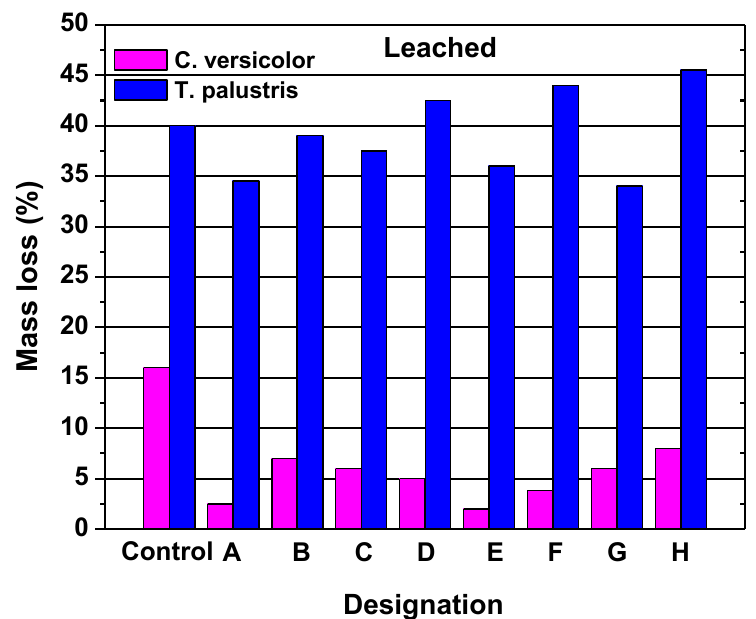
Figure 6. The mass loss (%) following a decay test for leached pine wood: ( A ) nanozinc oxide; ( B ) nanozinc oxide plus binder A; ( C ) nanozinc oxide plus binder B; ( D ) nanozinc borate; ( E ) nanozinc borate plus binder A; ( F ) nano-copper oxide; ( G ) nano-copper oxide plus binder A; and ( H ) nano-copper oxide plus binder B. Reprinted with permission from [78], Copyright Elsevier, 2014.